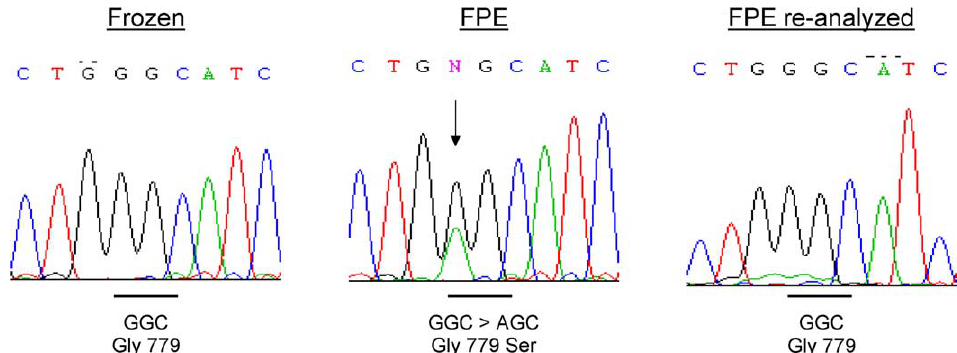
Fig. 1. Sequence chromatograms for sample #3977909 showing a wild type sequence when DNA from frozen tissue was used as template for PCR, whereas when DNA extracted from the fixed and paraffin embedded (FPE) sample was used as template for PCR, a mutation in exon 20 could be observed, Gly779Ser (arrow). Re-analyzing this fixed and paraffin embedded sample revealed a wild type sequence.